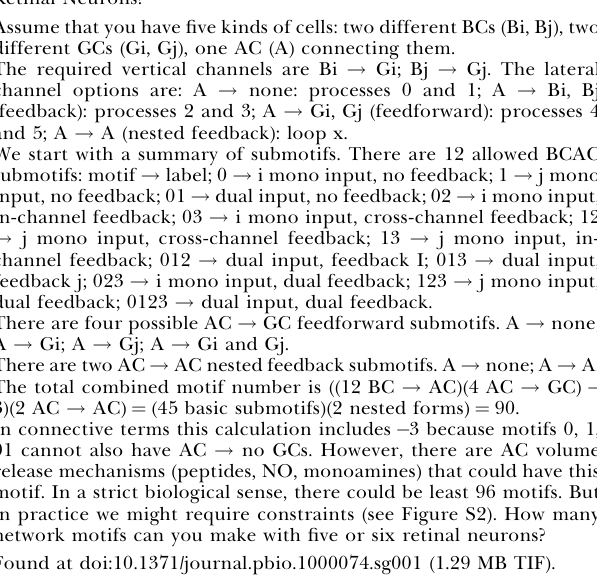
Figure 10 of the manuscript. Each instance of a BC synaptic ribbon in B1 is denoted by an aqua dot for the duration of the ribbon across slices.